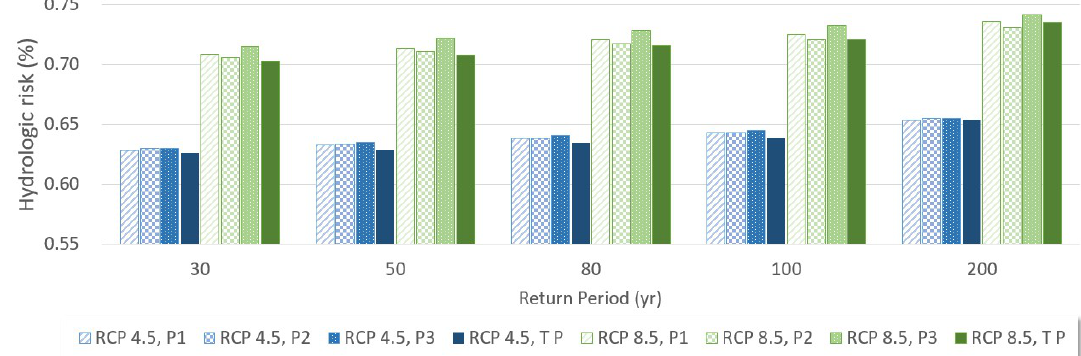
Figure 5. Average risks according to RCP scenarios and different time frames.